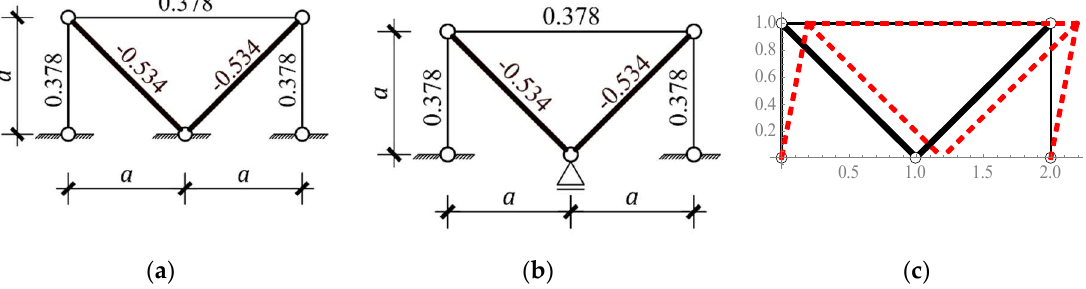
Figure 12. Truss with no tensegrity features: ( a ) values of self-stress state, ( c ) mechanism for truss